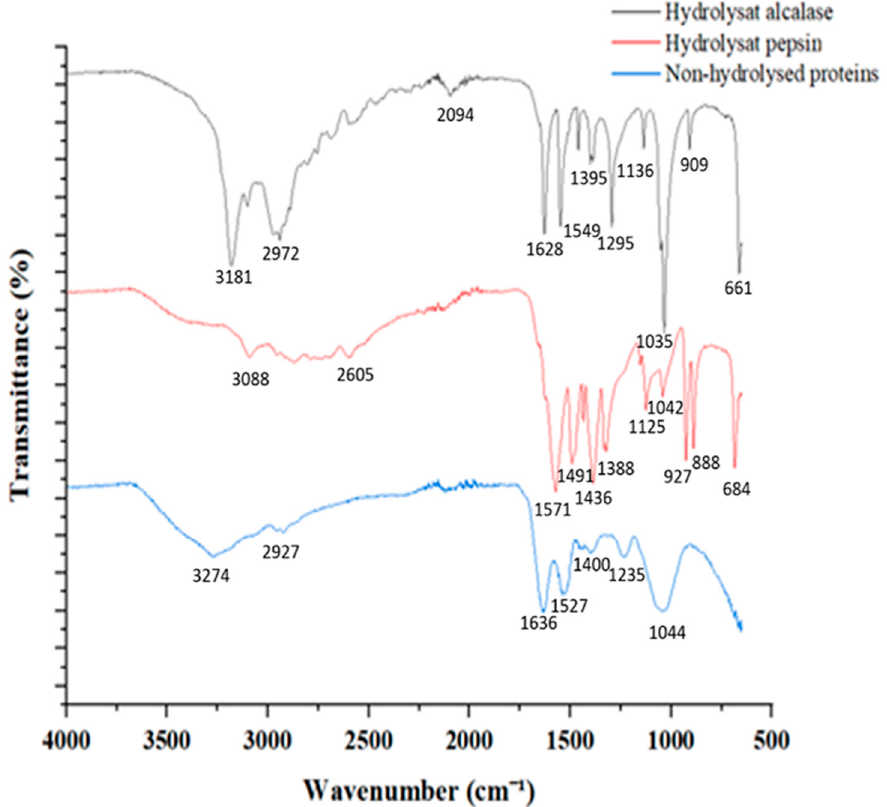
Figure 3. FTIR spectra of Rhodomonas sp. crude protein and peptides produced after alcalase and pepsin hydrolysis.